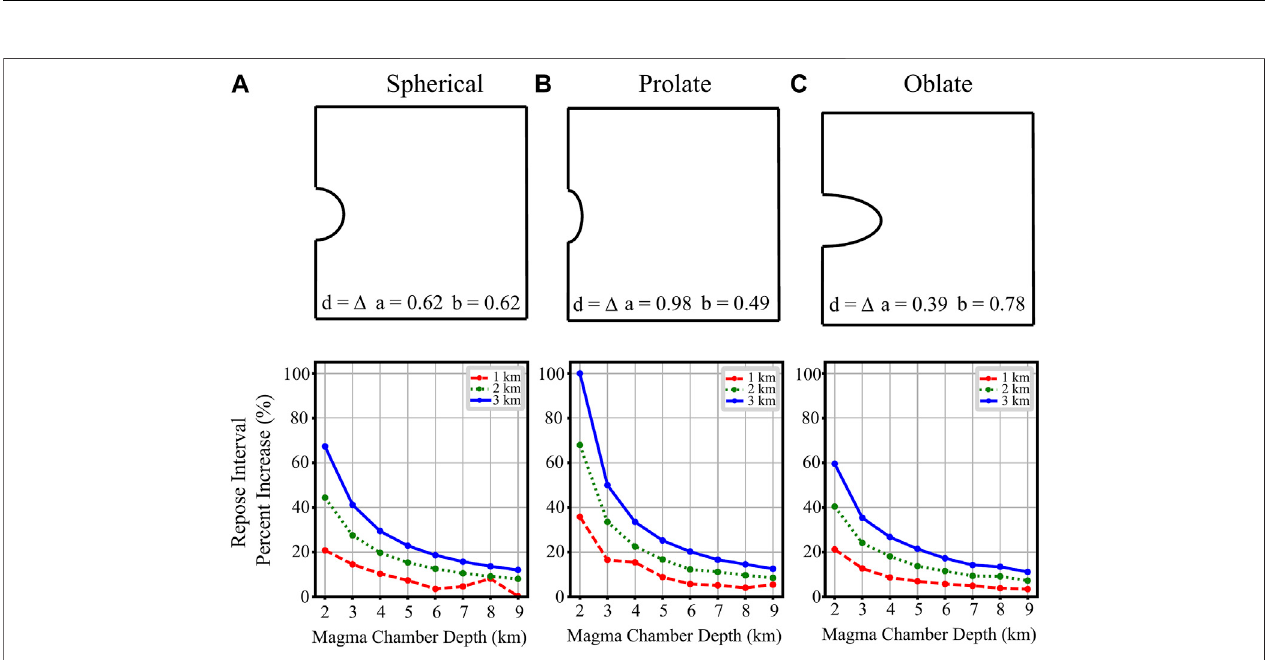
FIGURE 5 | Depth versus percent change in the repose intervals of volcanic systems with spherical, prolate, and oblate magma chamber geometries. The fl ux remains constant at a rate of 0.0024 km 3 /yr. (A) Depth to the center of the magma chamber ranges from 2-9 km, and the spherical chamber radius of 0.62 km remains constant.Percentchangesduetoanicecapthicknessof1,2,and3 kmarerepresentedbythedashedredline,dottedgreenline,andsolidbluelinerespectively.Asthe depthofthemagmachamberincreases,theeffectoftheicecaponthereposeintervalpercentchangegenerallydecreasesforeachicecapthickness.Thispattern is also found for the magma systems with prolate and oblate magma chambers. (B) Depth of magma chamber center versus percent change in the repose interval of a prolate chamber. Depth varies from 2-9 km, but vertical radius and horizontal radius remain constant at ~0.98 and 0.49 km respectively. (C) The percent change in repose interval as we vary depth and ice cap thickness is measured in a magma system with an oblate magma chamber. The horizontal radius is set at ~0.78 km while the vertical radius is ~0.39 km, and the depth to the center of the magma chamber ranges from 2-9 km.